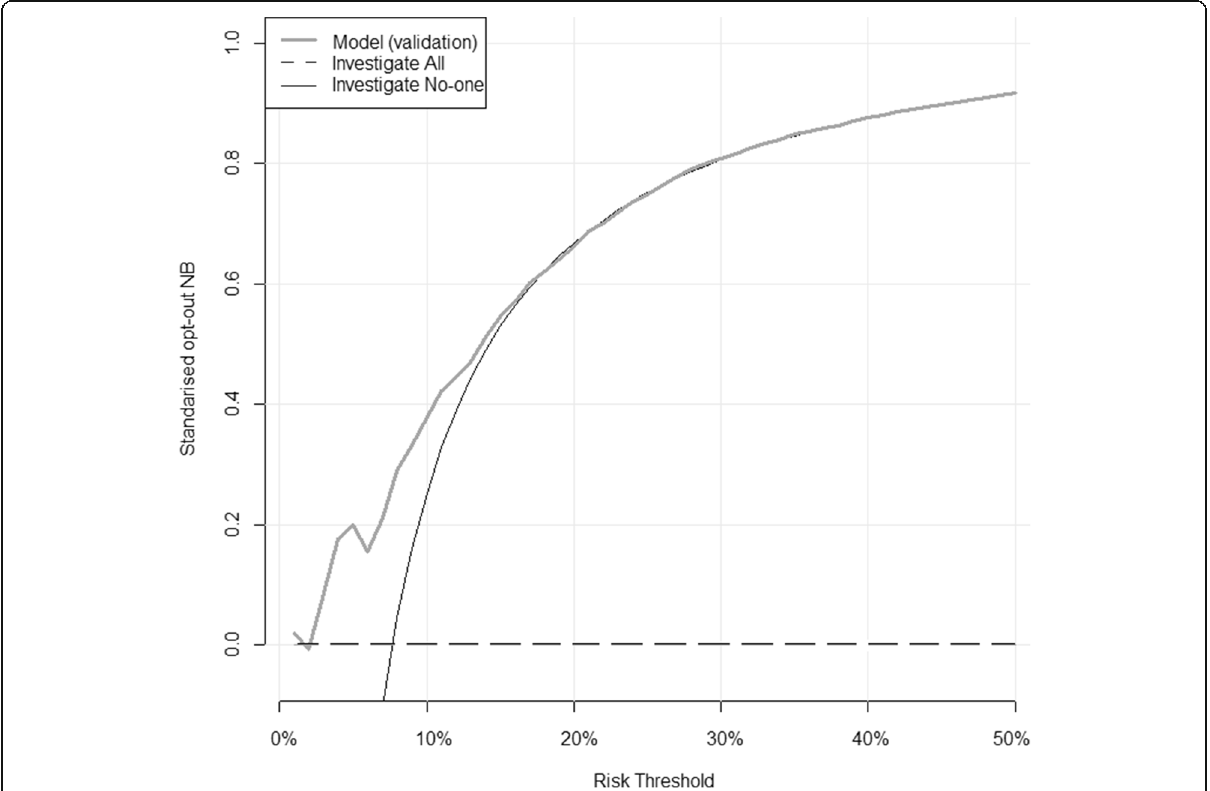
Fig. 4 Decision curve analysis for GI investigation using the combined external datasets. Grey line: penalised IDIOM model. Black line: ‘ investigate no-one ’ strategy. Dashed line: ‘ investigate all ’ strategy. The vertical axis displays standardised net benefit. The horizontal axis shows the risk